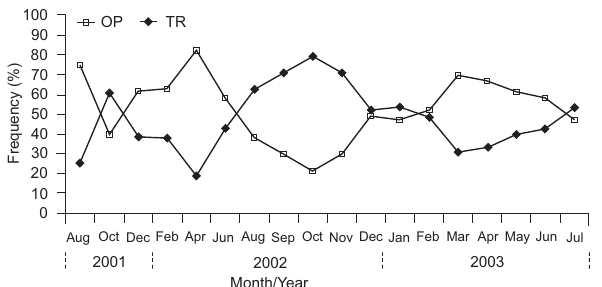
Figure 5. Monthly frequency (%) of opaque (OP) and translucent (TR) edges in otoliths of C. edentulus in the Saco dos Limões bight (southern Brazil).